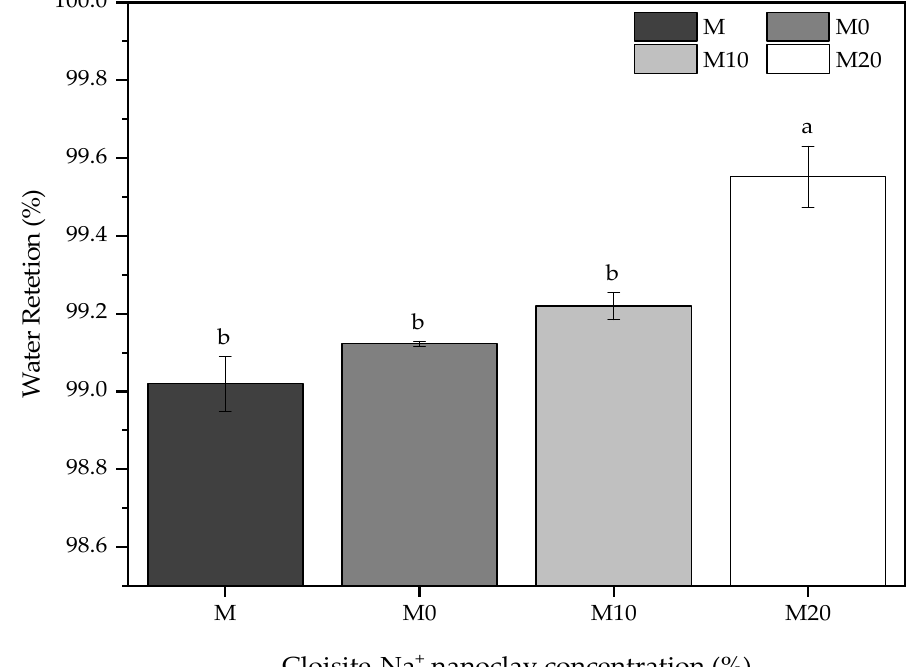
Figure 5. Comparative of the water retention for mortars containing nanocomposites prepared from different Cloisite-Na + nanoclay amount and water/cement of 0.40. Average with their respective standard deviation values followed by equal letters do not differ statistically from each other, following the Tukey test with a 95% confidence level.